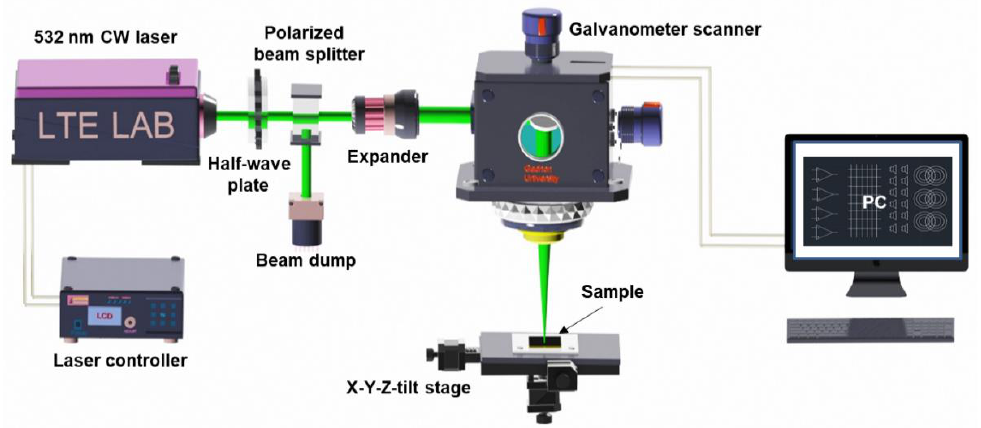
Figure 1. Schematic diagram of the laser setup for the laser digital patterning process to fabricate resistance tempera- ture